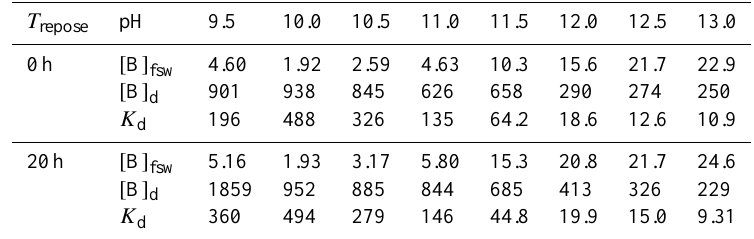
Table 2. Boron concentration (ppm) and partition coefficient K d between brucite deposit and final seawater. T repose pH